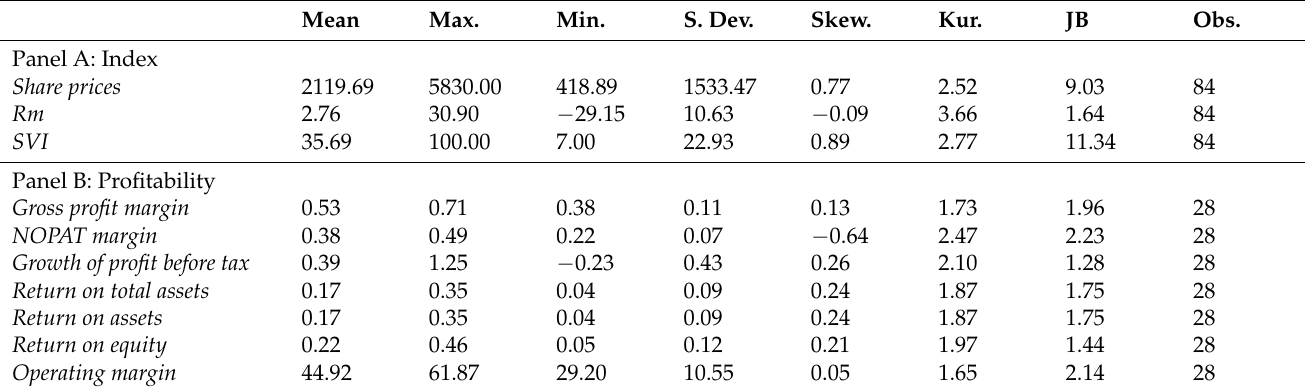
Table 1. Descriptive